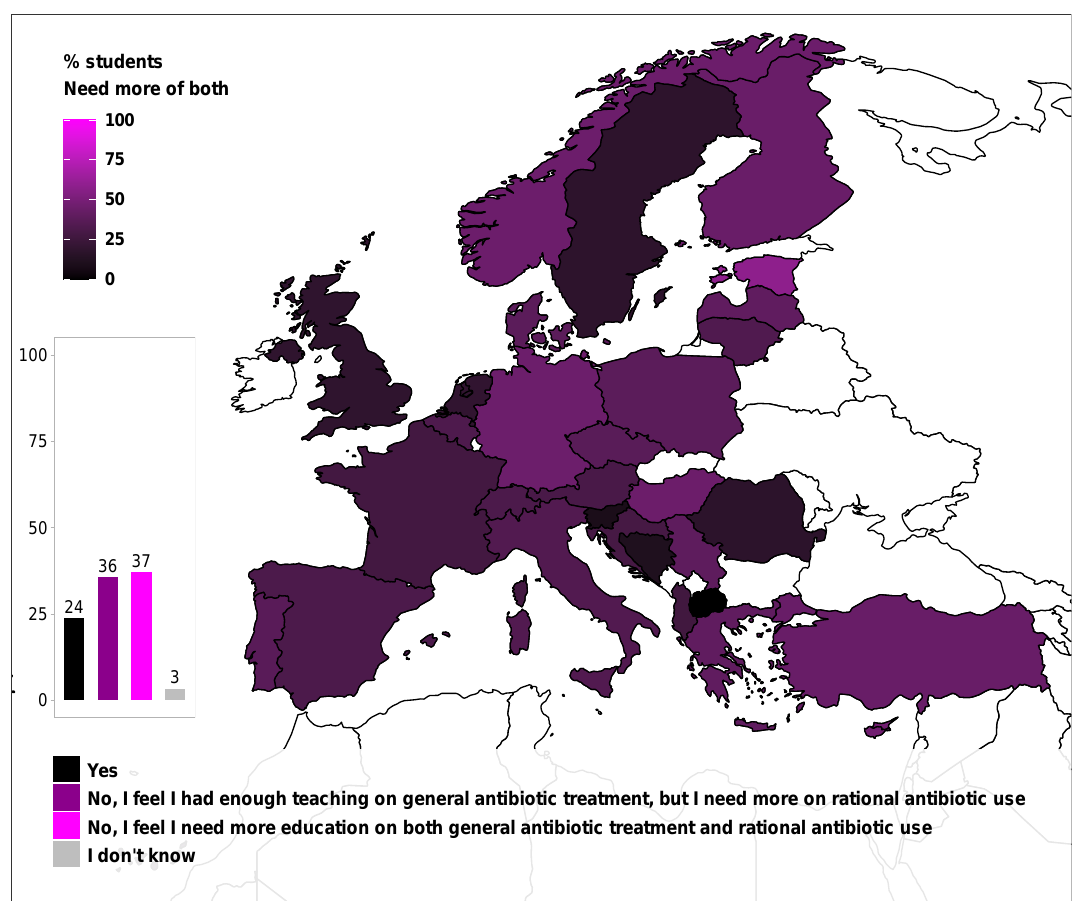
Figure 5. Satisfaction of final-year veterinary students about their knowledge in use of antimicrobial agents, as reported in question 27 of the survey: “Overall, do you think you receive adequate teaching to face antimicrobials and resistance issues in clinical practice?”. The bar plot shows the percentage of students selecting each of the answers available (bottom legend). The map displays the percentage of students that selected the answer: “No, I feel I need more education on both general antibiotic treatment and rational antibiotic use” (top-left legend). Bar plots may display added percentages above or below 100% due to rounding of the